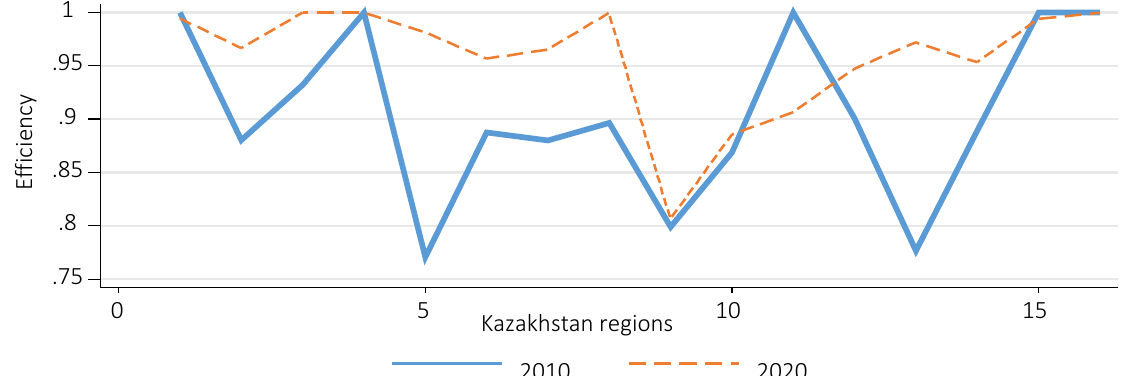
Figure 1. Comparison of the dynamics of Kazakhstan’s performance indicator from 2010 to 2020